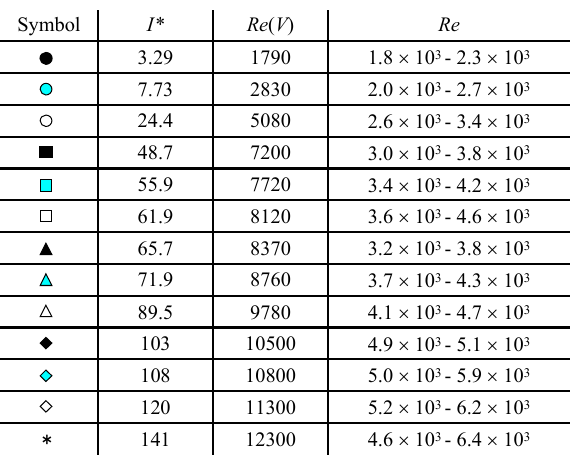
Table 2 Symbols and the corresponding I * , Re ( V ) and Re , in Figs. 11 - 20 ( λ = 0.3, AR = 10, C = 3.86 × 10 2